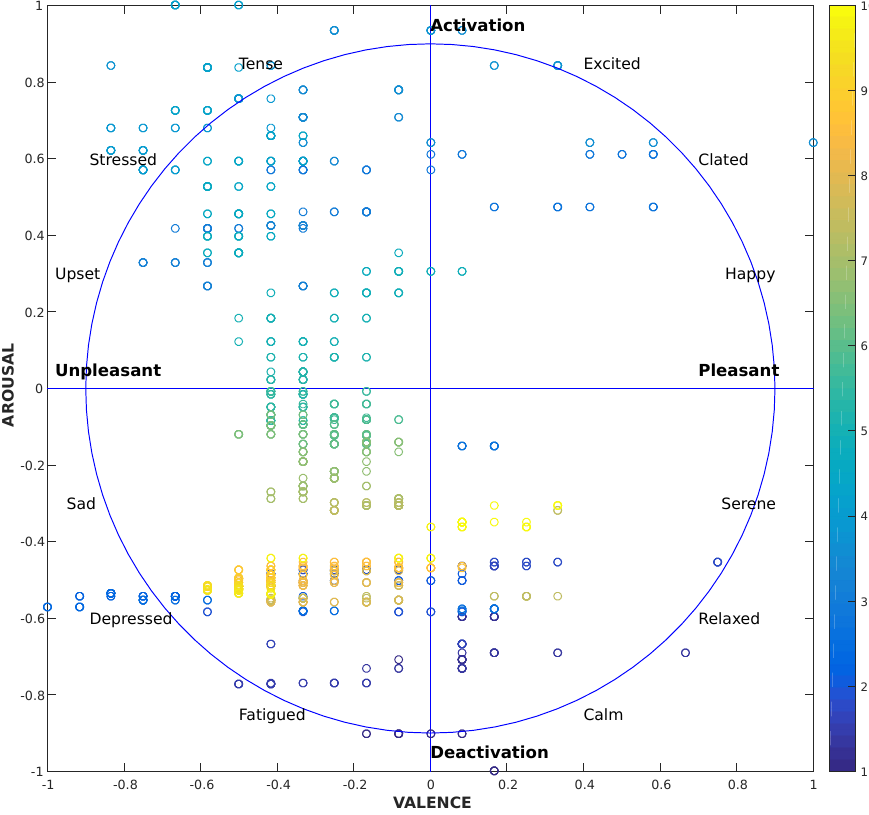
Figure 14. Valence–Arousal circumplex chart: on the x -axis the valence and on the y -axis the arousal of emotions. The data concentration in the left part of the graph can indicate that the type of exercise assigned by the therapist is too